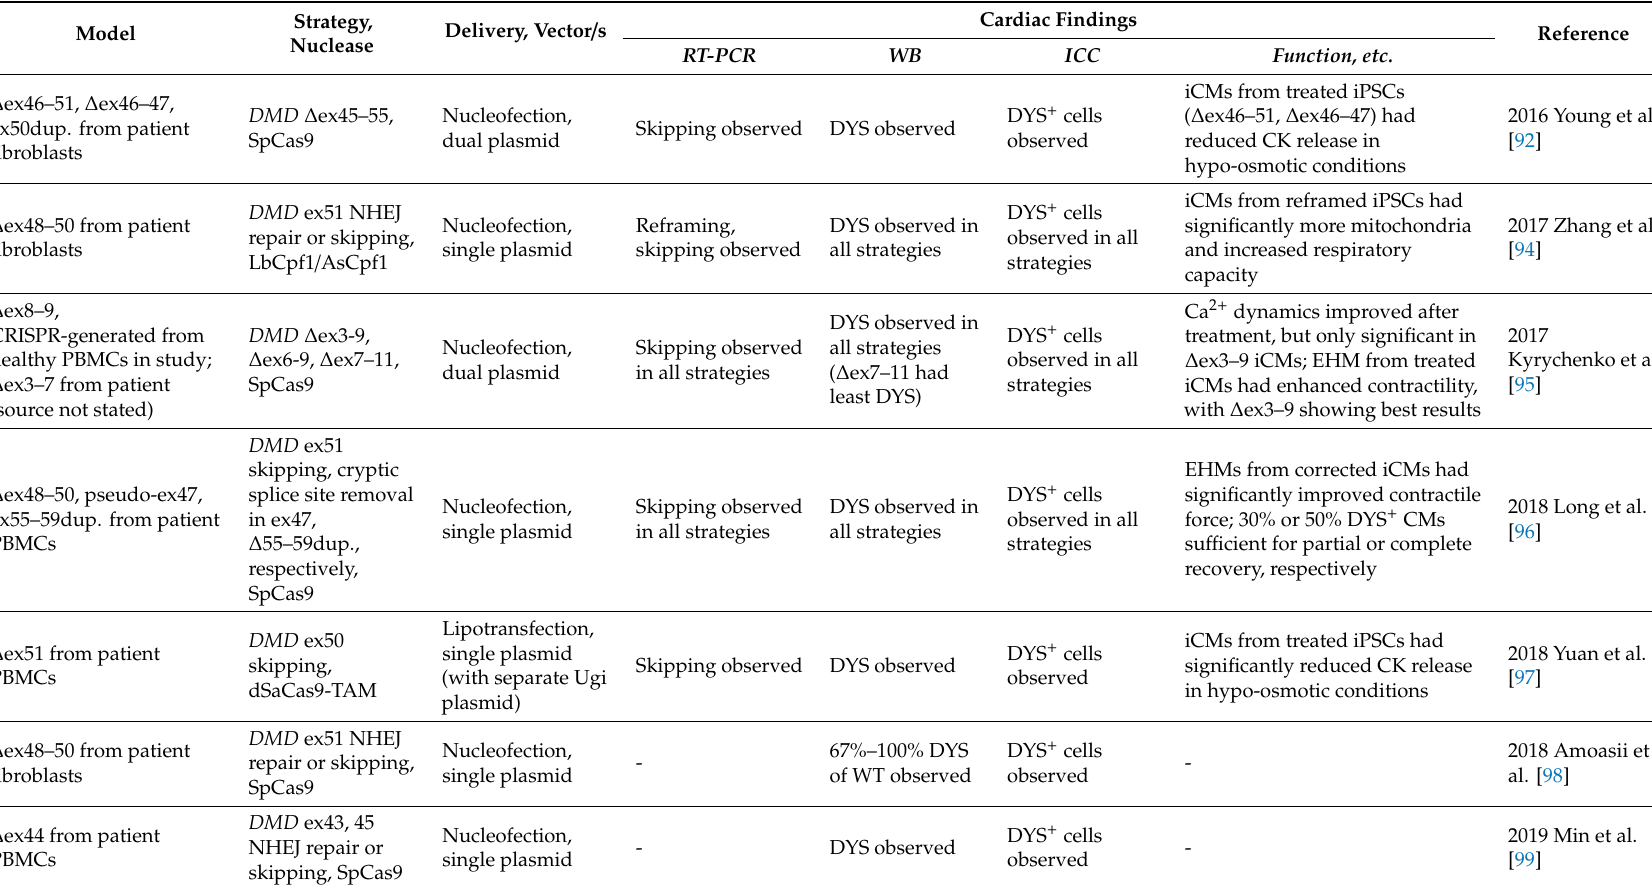
Table 1. Clustered regularly interspaced short palindromic repeats (CRISPR) studies on Duchenne muscular dystrophy (DMD) treatment using induced cardiomyocytes (iCMs) from human induced pluripotent stem cell